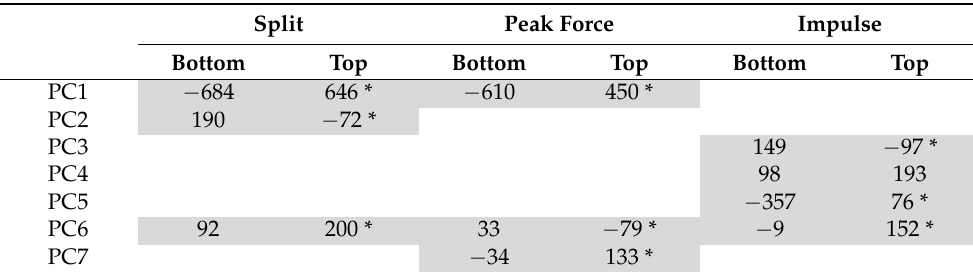
Table 1. Loading Scores means of Kinematic Patterns based on Performance Metrics top and bottom 100 for Principal Components 1–7. * Significant to bottom, p < 0.05. Split Peak Force Impulse Bottom Top Bottom Top Bottom Top PC1 − 684 646 * − 610 450 * PC2 190 − 72 * 149